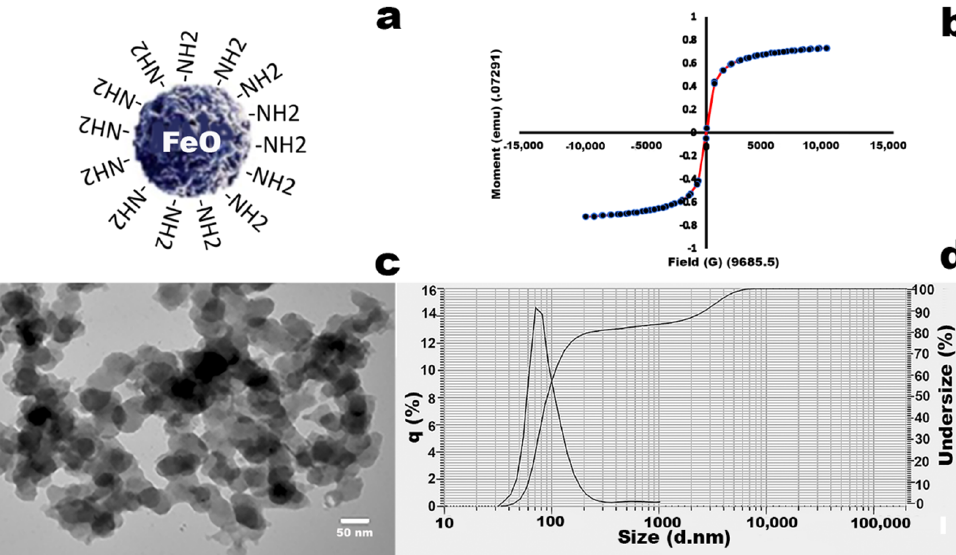
Figure 2. Characterization of MNP. ( a ) MNP structural scheme; ( b ) VSM analysis of MNP. ( c ) shows the TEM results for size and shape. ( d ) DLS analysis shows that the hydrodynamic size distribution of MNP.